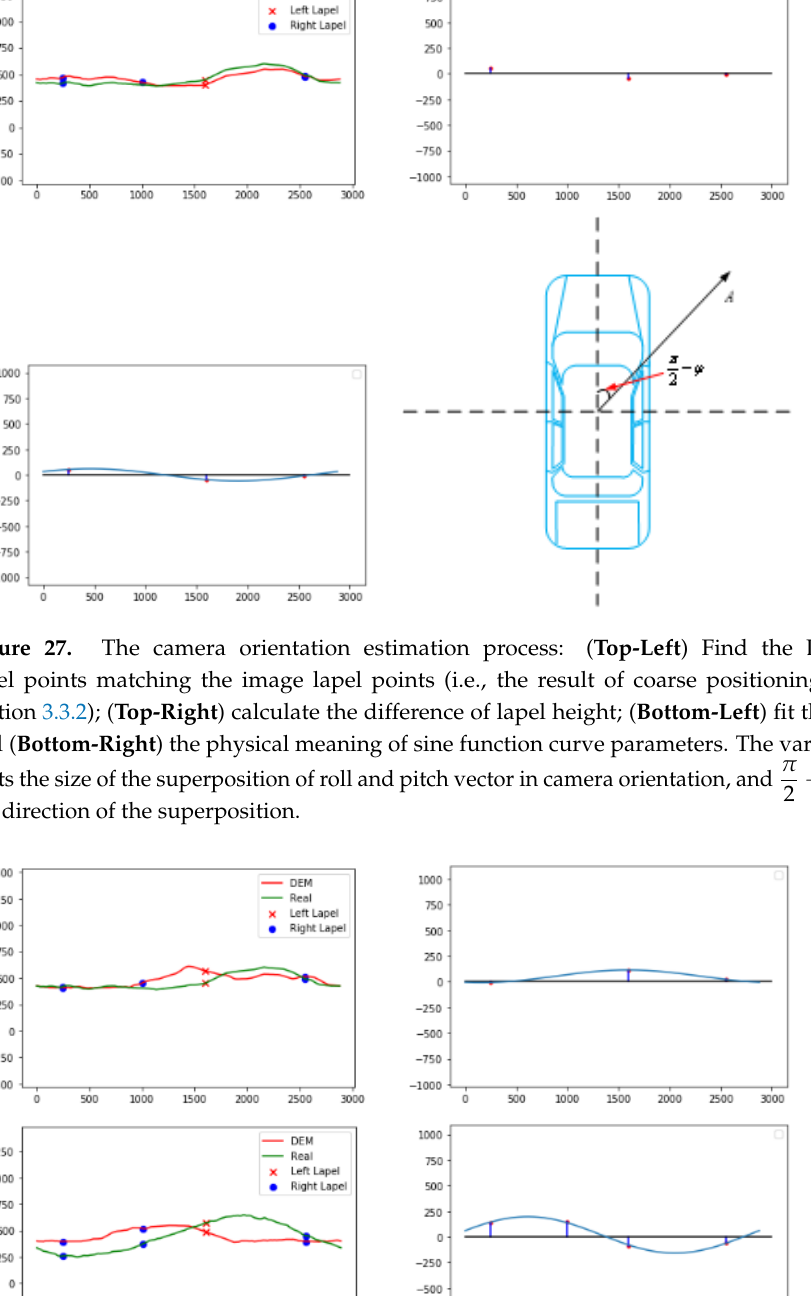
Figure 28. The sine fitting results of mismatched skyline pairs: ( Top row ) h is large and the entire sine function shifts upward; and ( Bottom row ) the vertical offset of sine function is